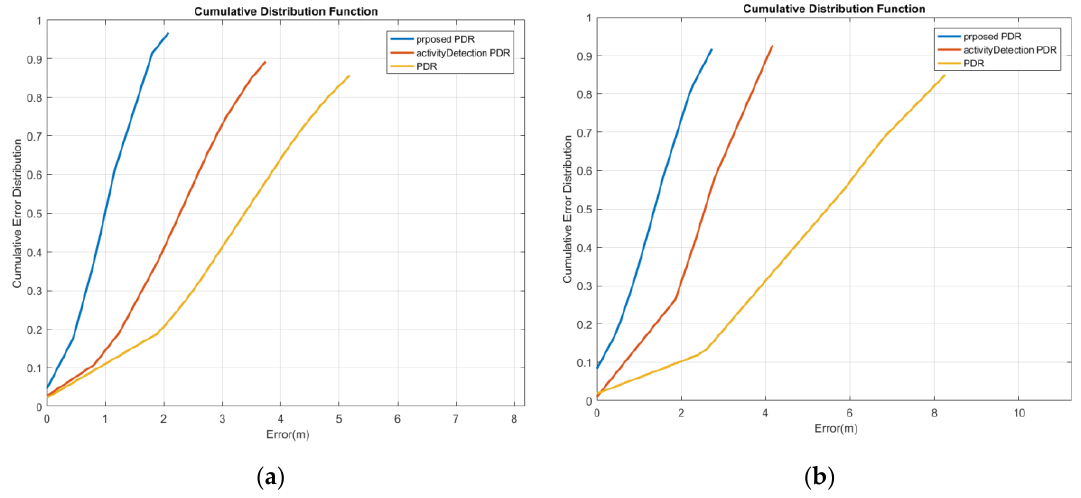
Figure 20. Cumulative error distribution of the calling mode; ( a ) woman; ( b ) man.